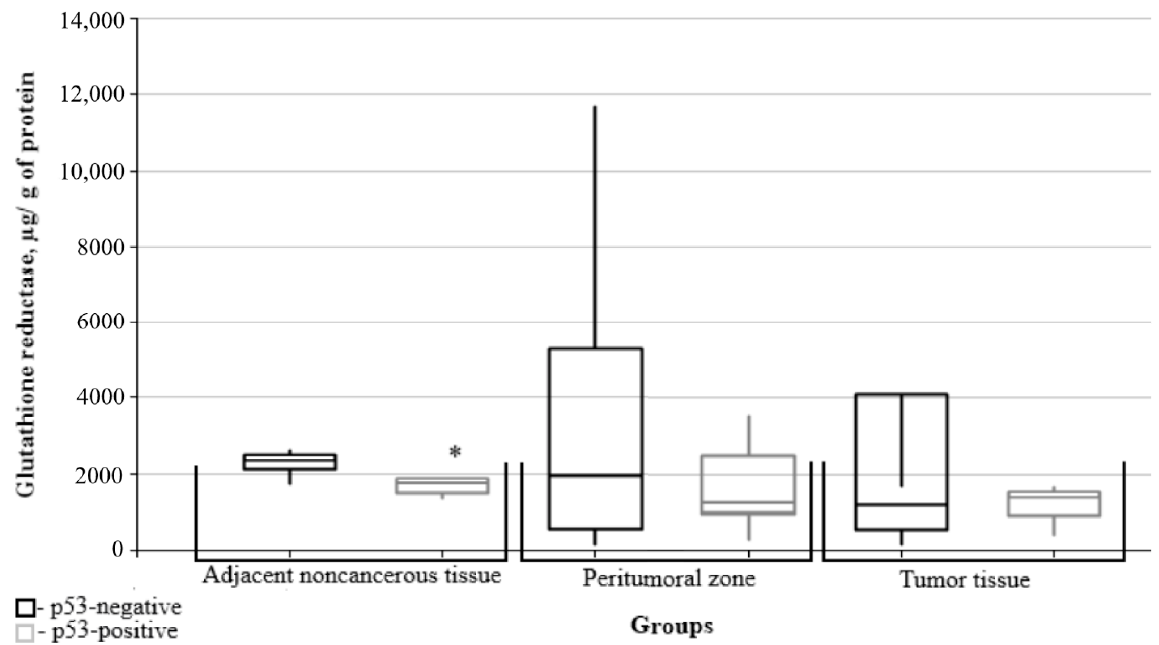
Figure 10. Medians and interquartile ranges (IQRs) of the glutathione reductase levels in gliomal tissues as a function of the p53 protein tumor suppressor expression. There are significant differences between glutathione reductase levels in noncancerous tissues adjacent to the tumors of groups with/without expression of the p53 protein tumor suppressor (* ̵ Mann-Whitney U-test p = 0.043). Thus, it was found that the greatest number of glutathione system parameters de- pended on the value of the mitotic index Ki-67, i.e., the levels of oxidized and reduced glutathione, glutathione peroxidase and glutathione transferase. Mutations of the iso- citrate dehydrogenase IDH1 isoenzyme gene affected the content of reduced glutathione and glutathione peroxidase. Expression of the p53 protein tumor suppressor affected the content of glutathione peroxidase in the tumor tissue and of the glutathione reductase levels in adjacent noncancerous tissues. No significant differences were found between the indices of glutathione metabolism and of MGMT gene promoter methylation. 4. Discussion It is now becoming clear that standard methods of radiation diagnosis and histolog- ical examination are often insufficient to correctly determine the prognostic potential of brain tumors. Groupings of gliomas based on their malignancy grade are not homogeneous with respect to the aggressiveness of their behaviour and responses to treatment. Furthermore, isolated markers like Ki-67, IDH, p53, and MGMT promoter methylation have limited predictive value. Glutathione and the enzymes involved in its metabolism may, in some cases, be re- sponsible for resistance to certain therapies. The study of glutathione levels in relation to